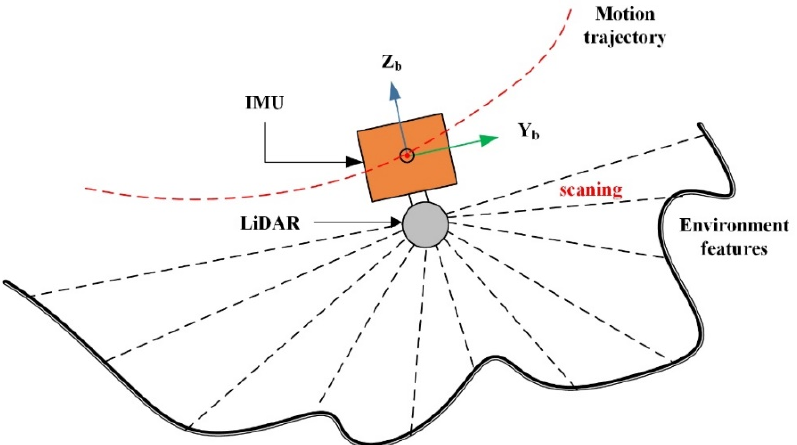
Figure 1. LiDAR-IMU measurement system.